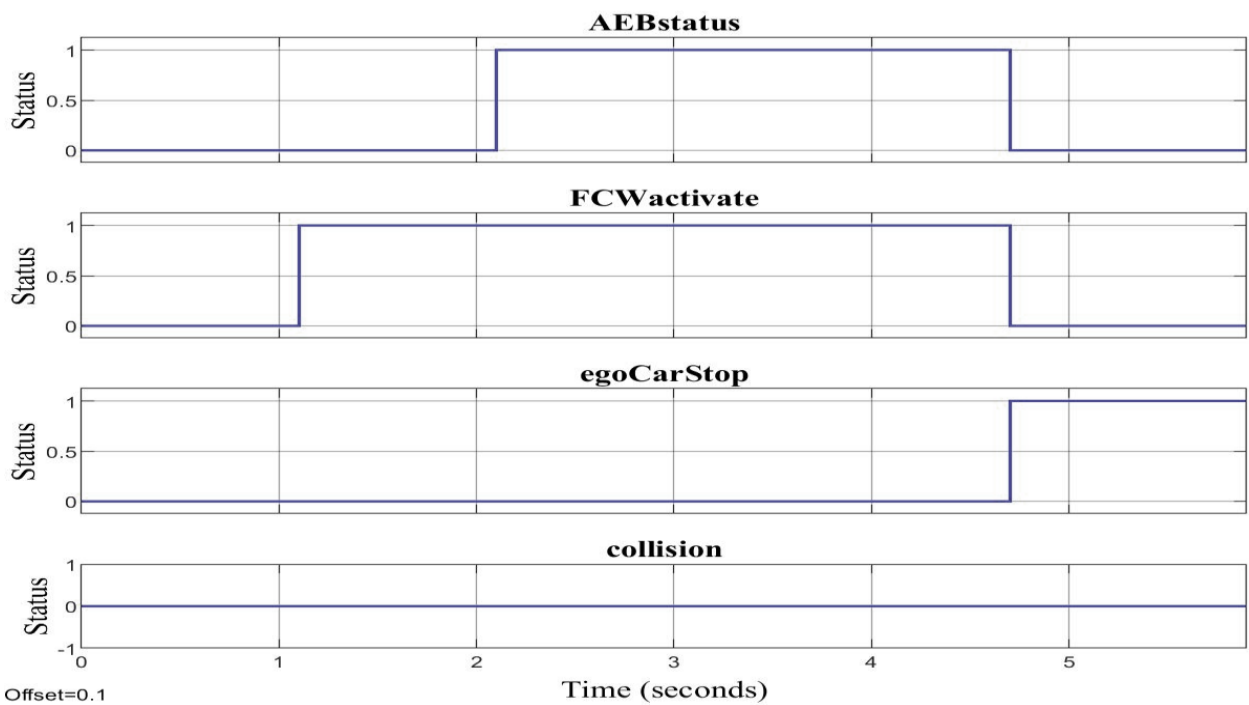
Figure 15. Sensors measured detections and calculated detections with sensor fusion.